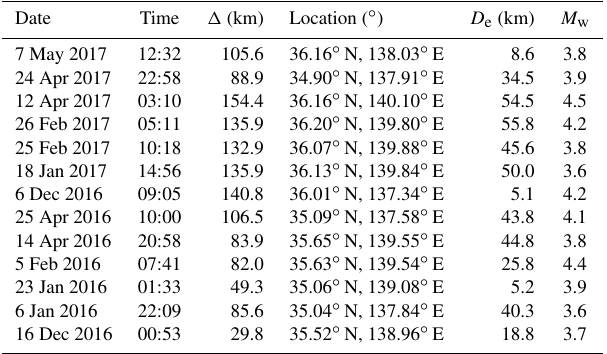
Table 2. Date, time, epicentral distance ( (cid:49) ), epicenter location (lat- itude, longitude), depth ( D e ), and magnitude M w of the local earth- quakes whose coda waves were used to estimate the site amplifica- tion factors (source: JMA). Epicentral distances refer to the location of station E.NAG.